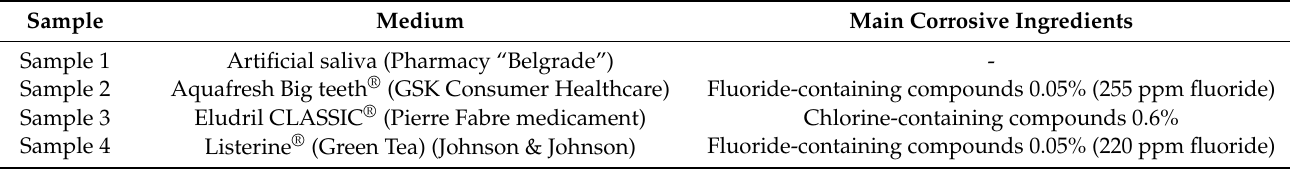
Table 1. Sample denotations, used media, and their main corrosive